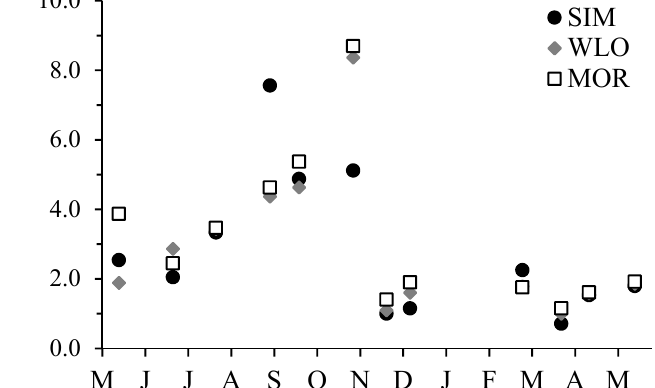
Figure 6. DIC:DOC ratios in the Atchafalaya River at its upstream location (Simmesport) and two outlets (Wax Lake Outlet and Morgan City) from May 2015 to May 2016 (no ratio is available for the sampling event on 31 January 2016).